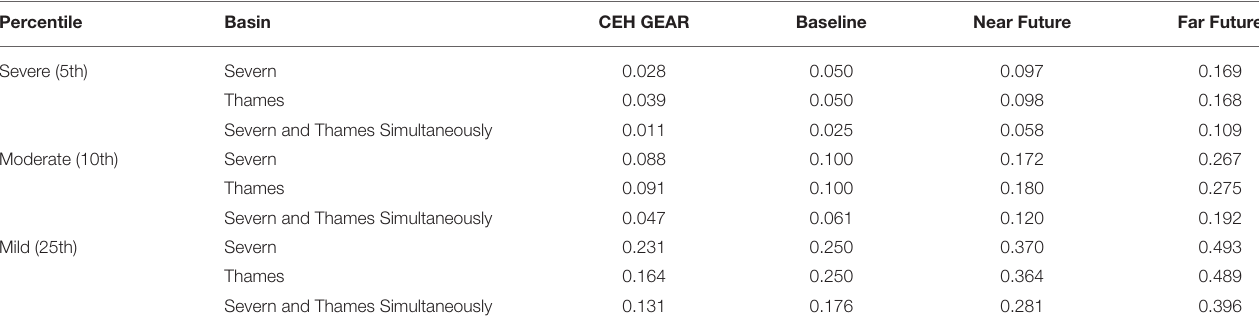
TABLE 5 | Probability of months in Historic, Baseline, Near Future, and Far Future flow ensembles with 12-months SRI values < W@H Baseline 5, 10, and 25th percentiles for Thames and Severn study areas, individually and simultaneously.